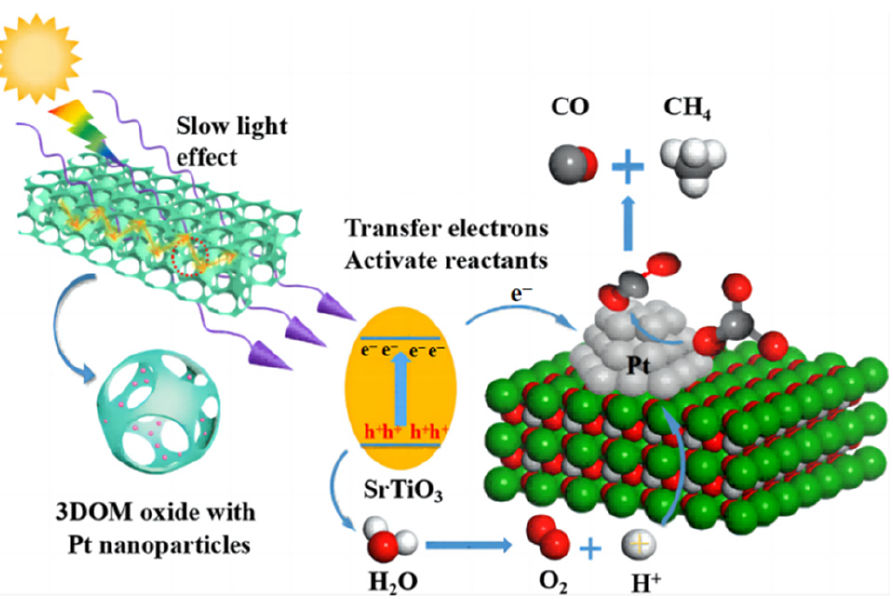
Figure 8. The possible mechanisms of the photocatalytic CO 2 reduction over Pt/3DOM SrTiO 3 [46]. A two-dimensional MoS 2 layers/3DOM TiO 2 photocatalyst was prepared [47] to form heterojunctions, which had a higher performance in the range of 420–900 nm. Cu single atoms were uniformly distributed in 3DOM TiO 2 via the in situ method [48], which provides active sites for CO 2 photoconversion. The main products tested in the gas–solid two-phase system were CH 4 and C 2 H 4 with the corresponding generation rates of 43.15 and